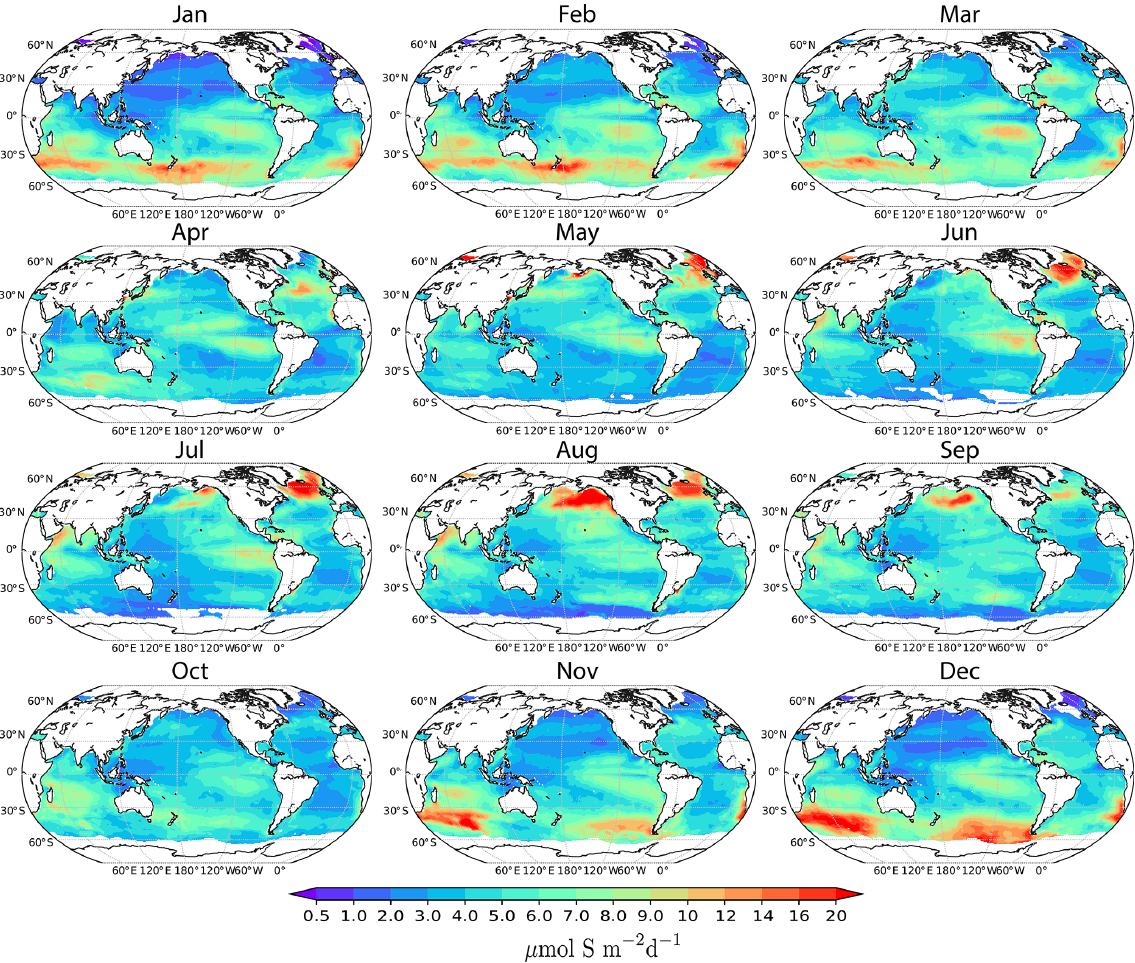
Figure 7. Monthly DMS flux (µmolSm − 2 d − 1 ) calculated based on DMS climatology estimated from the ANN model and Goddijn-Murphy et al. (2012) flux